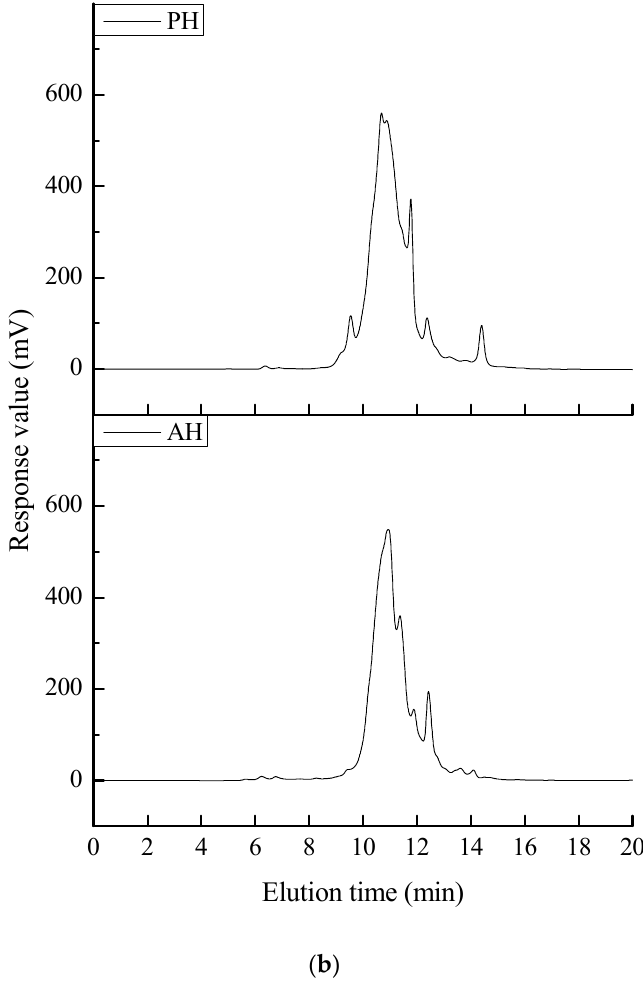
Figure 1. ( a ) Calibration curve of standard substances on TSK-gel G3000 PWXL column at 220 nm. The five standard substances were bovine serum albumin (67,000 Da), peroxidase (40,200 Da), ribonuclease A (13,700 Da), glycine tetramer (246 Da) and p-Aminobenzoic acid (137.14 Da), respectively; ( b ) Molecular weight distributions of PH (the hydrolysate prepared by Protamex hydrolysis) and AH (the hydrolysate prepared by Alcalase hydrolysis). PH and AH were eluted by 0.1 mol/L Na 2 SO 4 in 0.1 mol/L phosphate buffer (pH 6.7) at a flow rate of 1 ml/min and monitored at 220 nm at 25 °C.